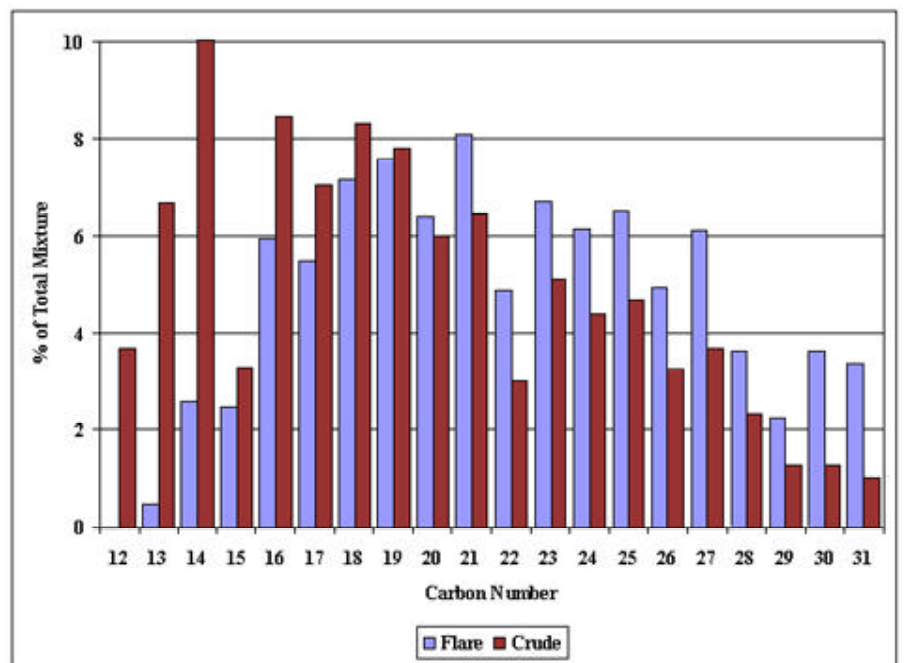
FIGURE 1 . Carbon number distribution for flare and crude mixtures.